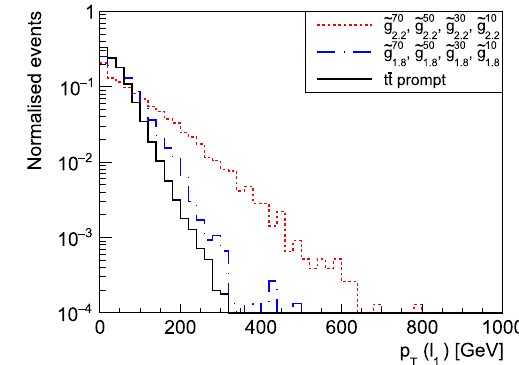
Fig. 74 Total transverse hadronic energy THT in the gluino ˜ g case